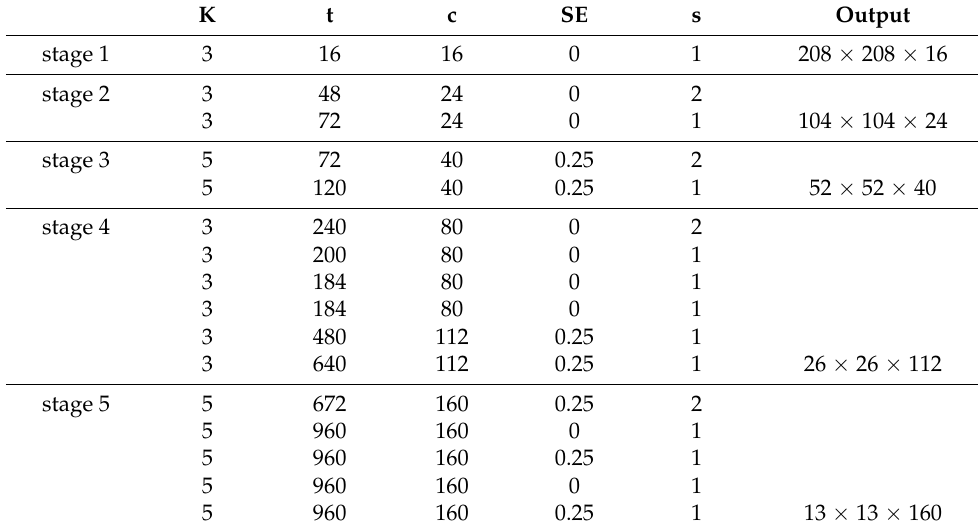
Table 2. Cfgs parameters.